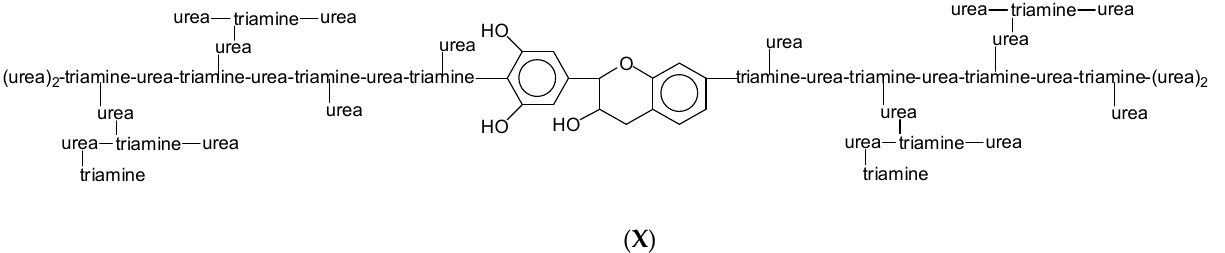
Figure 12. An example of a flavonoid unit linking two hyperbranched triamine-urea